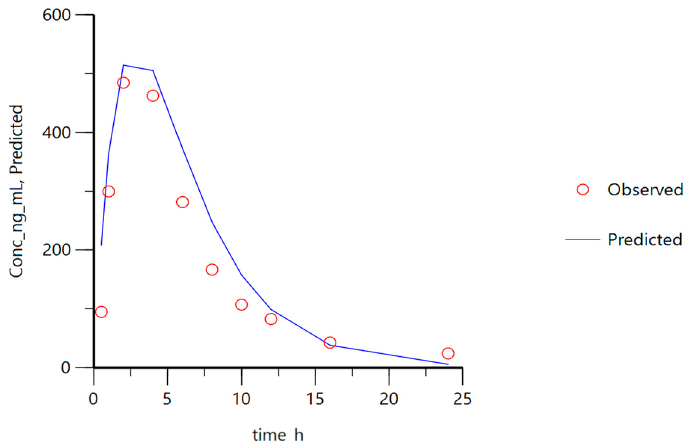
Figure 15. Plasma levels predicted with the proposed one-step IVIVC (based on four products) and the dissolution profile from the reference product from Okumu et al. [1]. The observed plasma levels correspond to the in vivo clinical data used by the same authors.